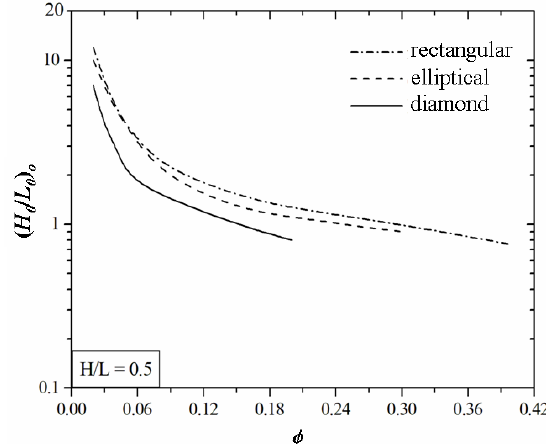
Figure 14. The once optimized rate of ( H hole volume fraction φ for all hole